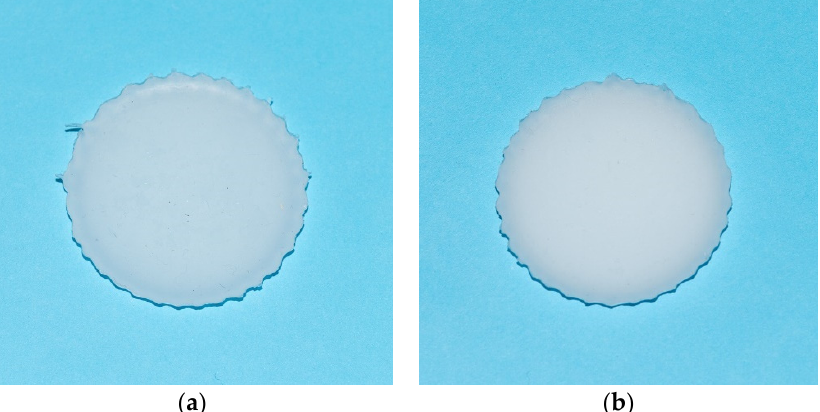
Figure 1. Investigated optical phantoms, where: ( a ) sample with 5 mL of glycerol, ( b ) sample with 2 mL of glycerol.